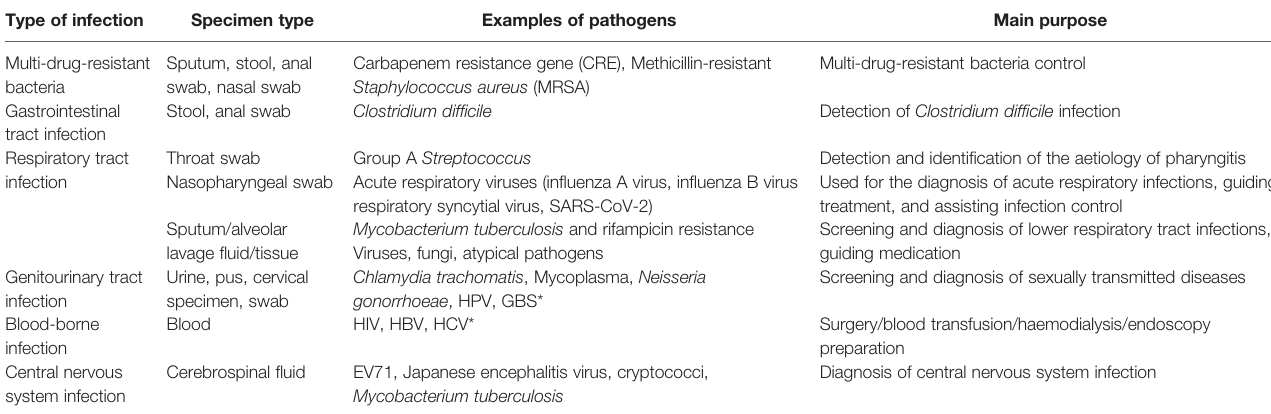
TABLE 2 | Common types of clinical specimens and their